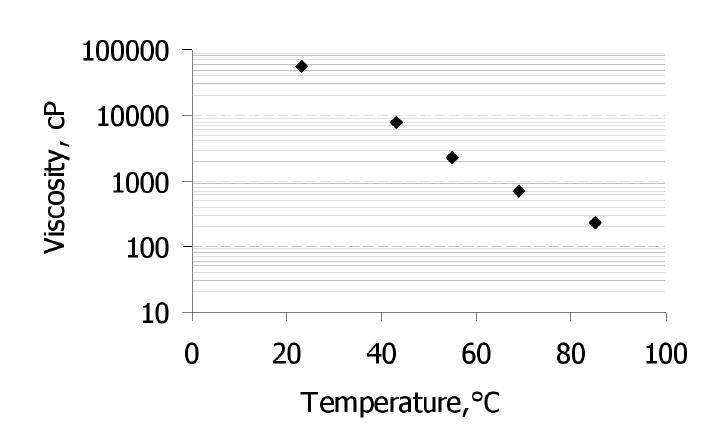
Fig. 7 Viscosity of Photomer 3015 vs.